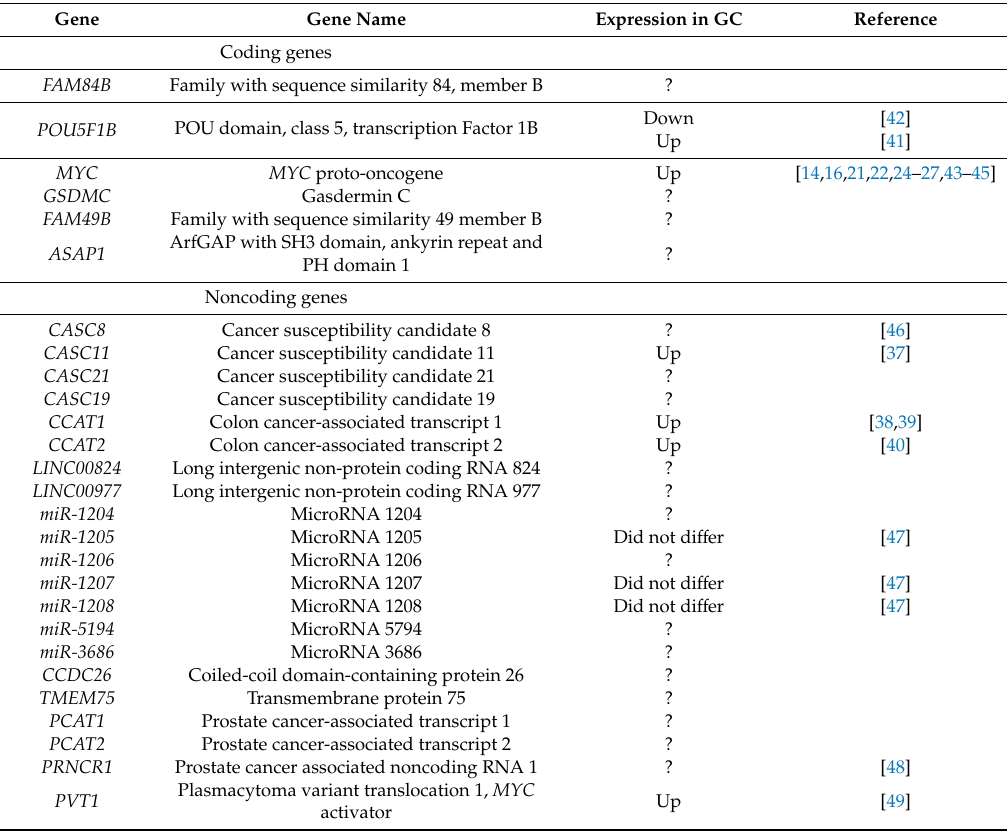
Table 1. Genes localized at 8q24.21